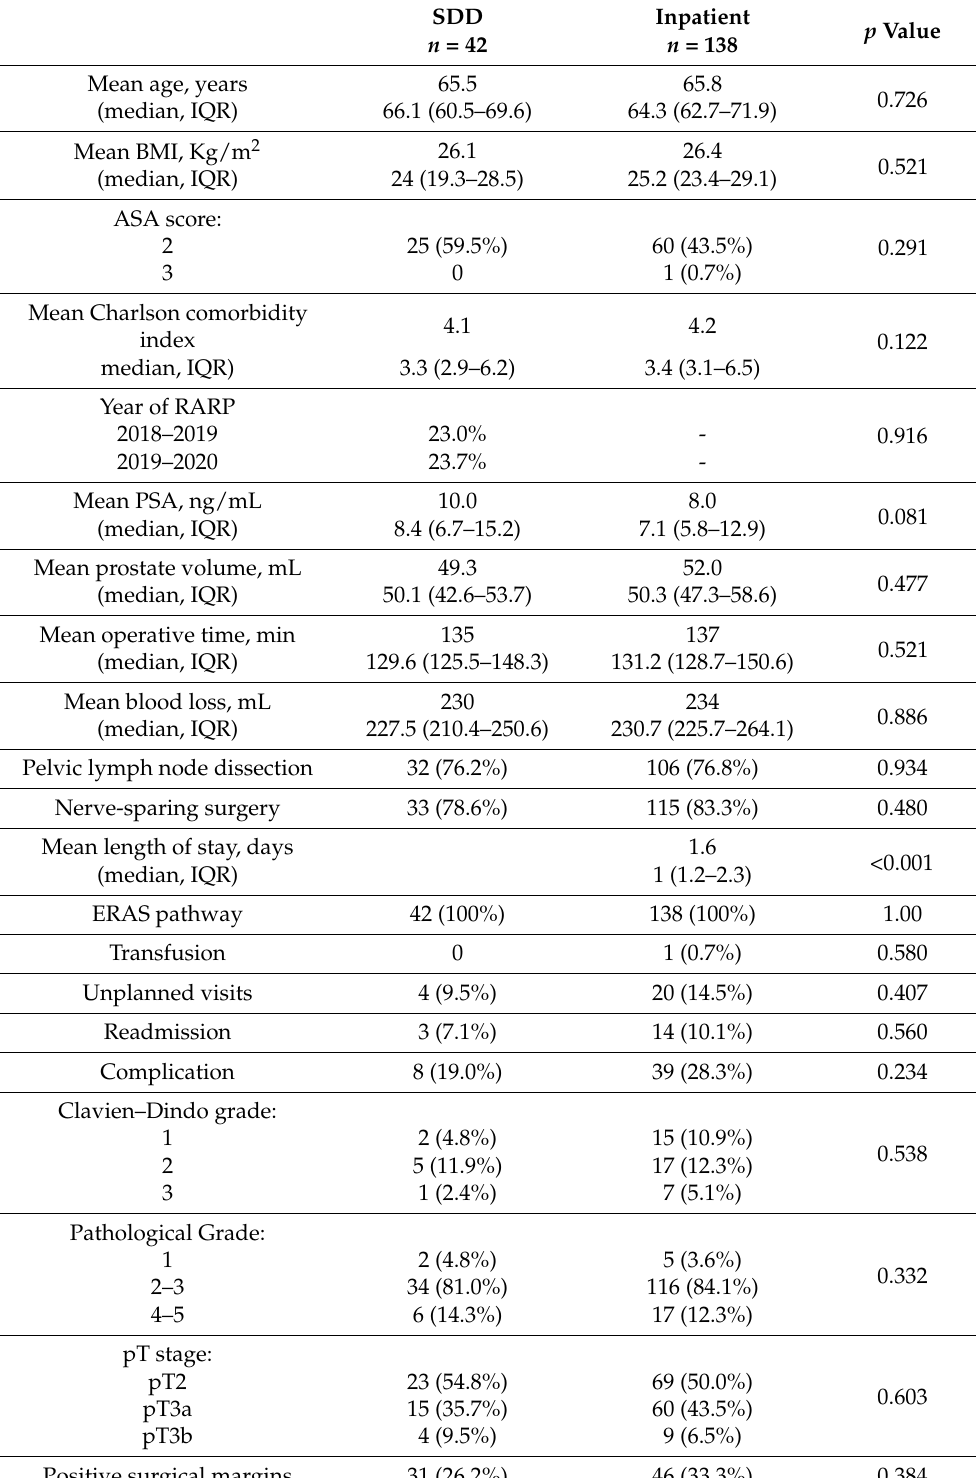
Table 2. Comparison between same day discharge (SDD) and inpatient robot-assisted radical prosta- tectomy (RARP)